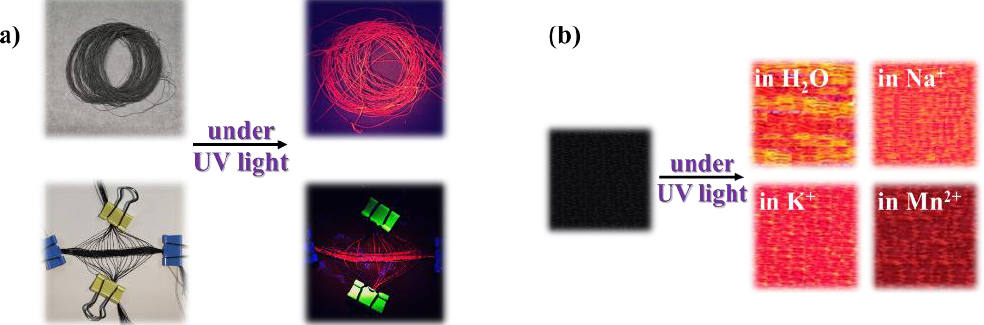
Figure 9. ( a ) UV-light response of E-uMWCNT-Fs and its fabric; ( b ) UV-light response of E-uMWCNT-F fabric in various liquid media.